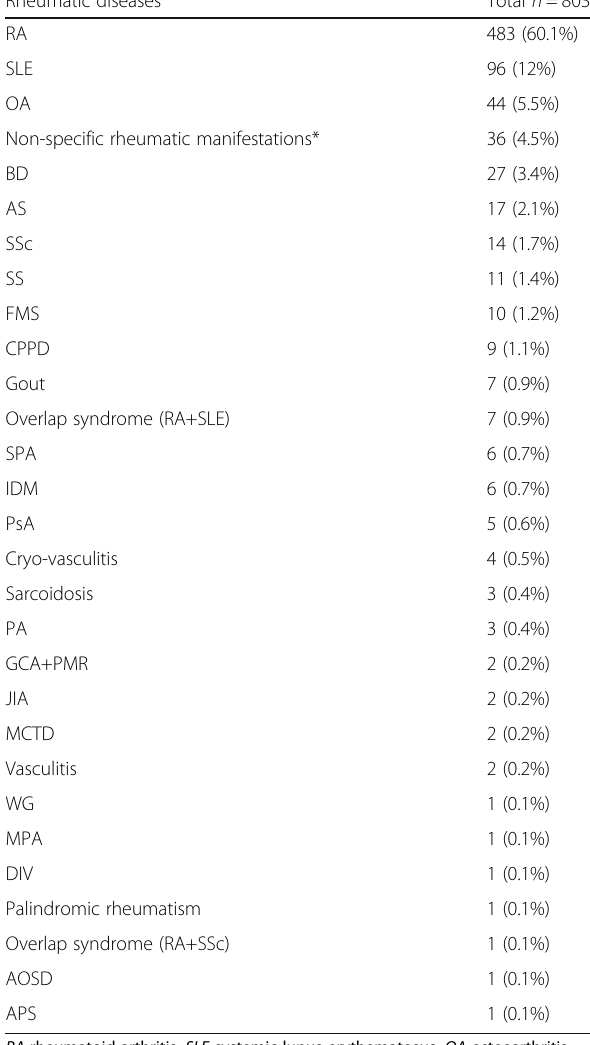
Table 2 Frequency of rheumatic diseases in the cohort Rheumatic